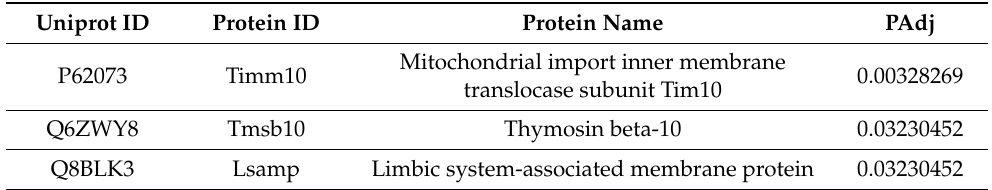
Table 1. List of DEPs after factorial two-way ANOVA with Bonferroni–Hochberg correction for the interaction “Time × Treatment”.